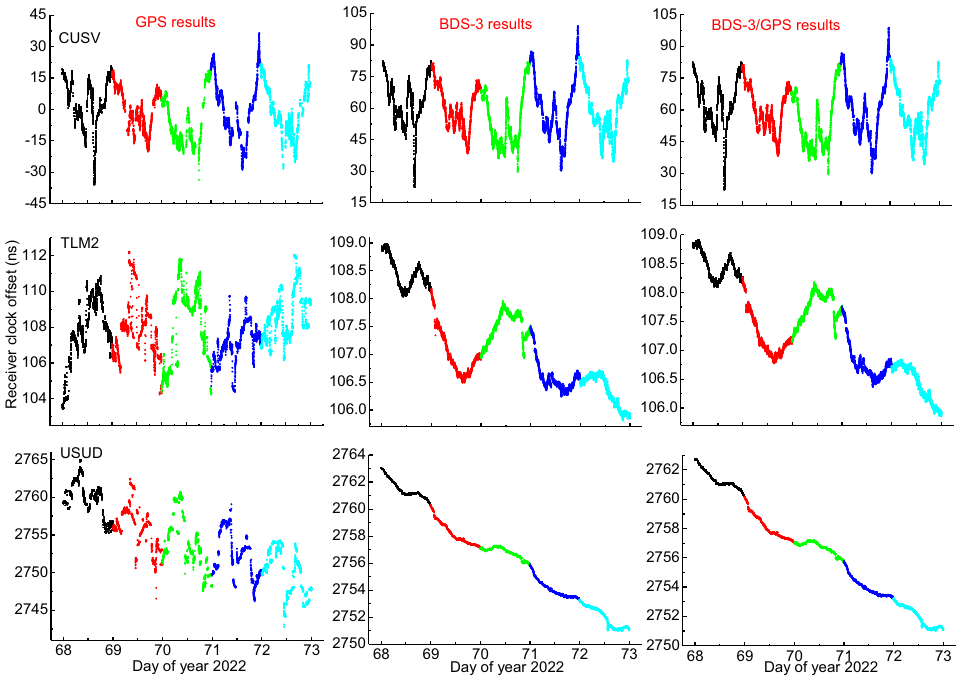
Fig. 2 Receiver clock offsets of CUSV, TLM2, and USUD stations from GPS, BDS-3, or BDS-3/GPS PPP in Scheme1. Different colors indicate the results of different